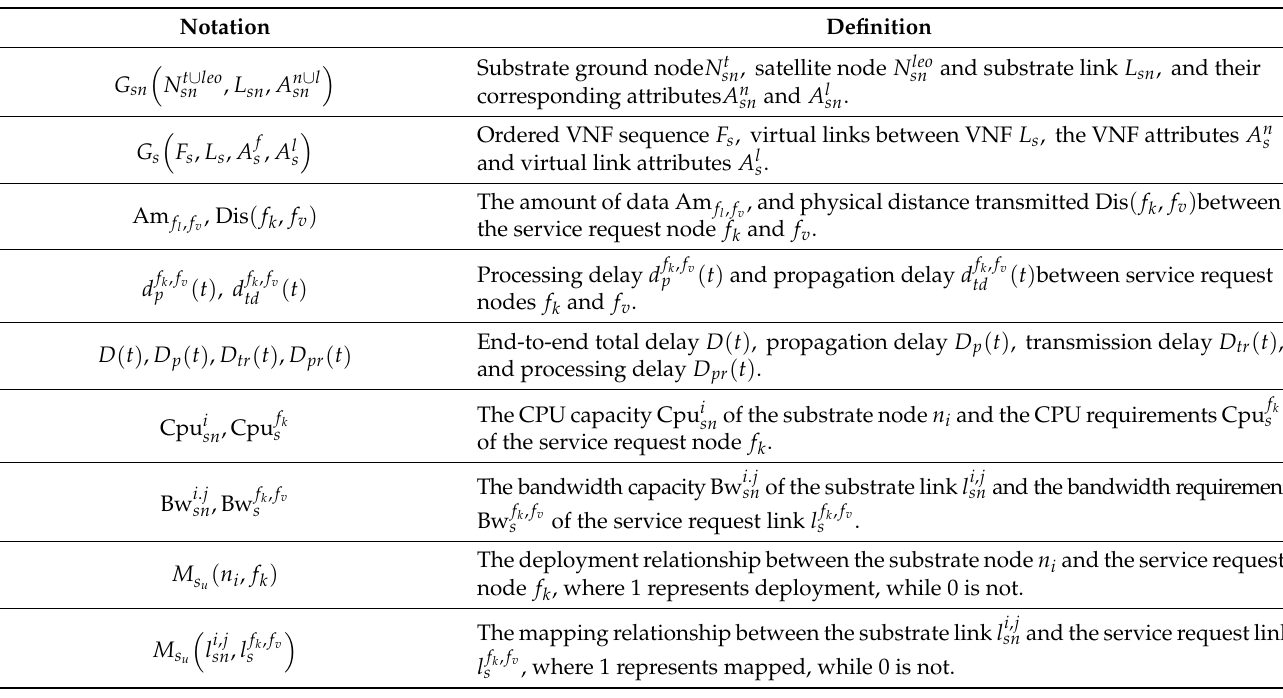
Table 1. Main notation and